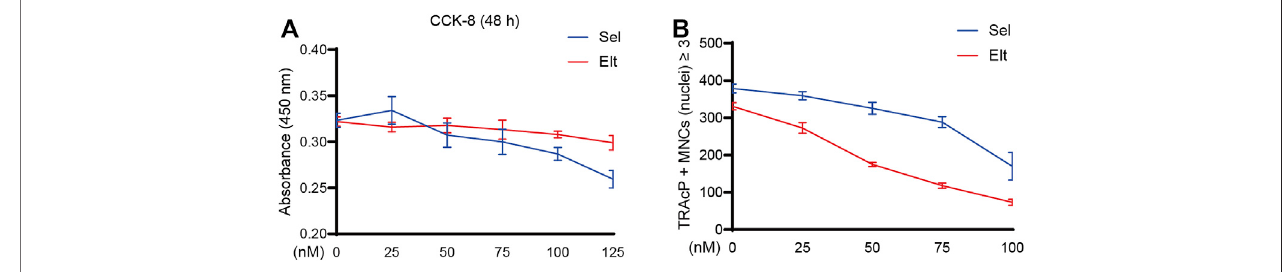
FIGURE 1 | The effects ofSel and Elt on cell cytotoxicity and osteoclast inhibition in vitro . (A) Cell viability ofSel and Elt-treated BMMs at 48 h. (B) Trend ofSel and Elt on RANKL-induced osteoclast inhibition. The above data are expressed as the mean ± SD; n ≥ 3. Differences arise from inside groups.